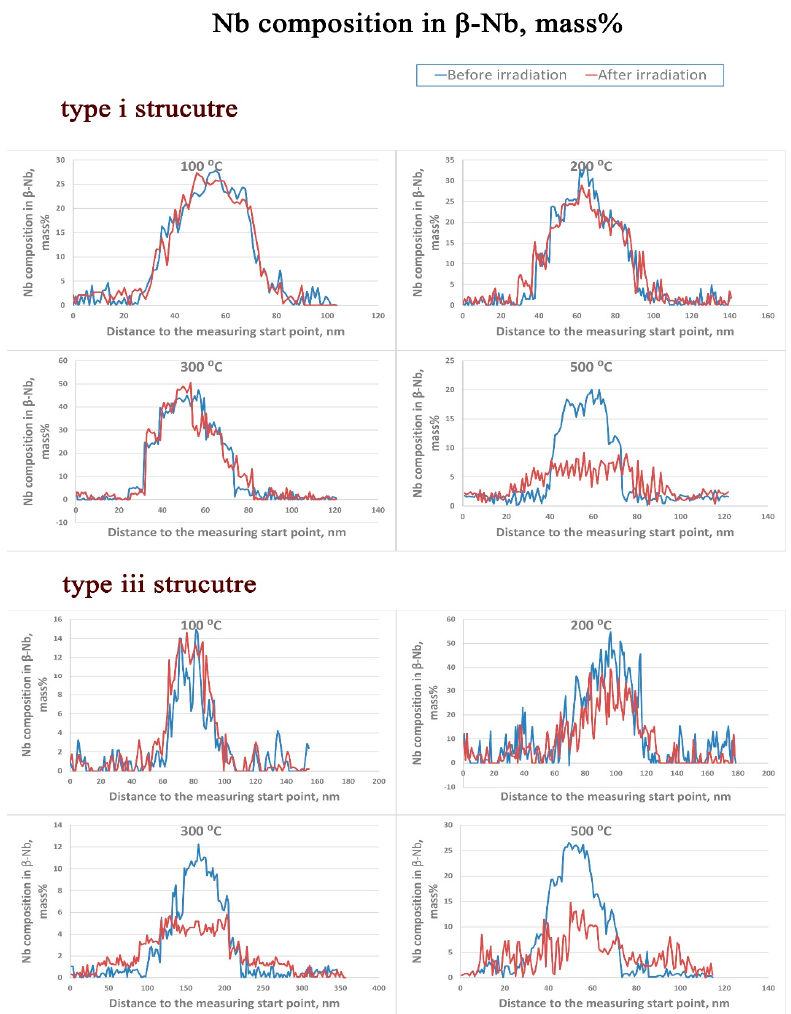
Figure 11. The concentration change of Nb in β –Nb precipitates in type i and iii structures before and after irradiation at 100 °C, 200 °C, 300 °C, and 500 °C.